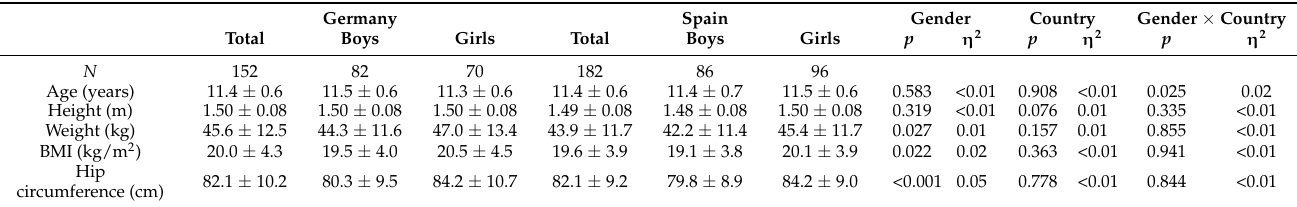
Table 1. Country characteristics divided by gender. Spain Gender